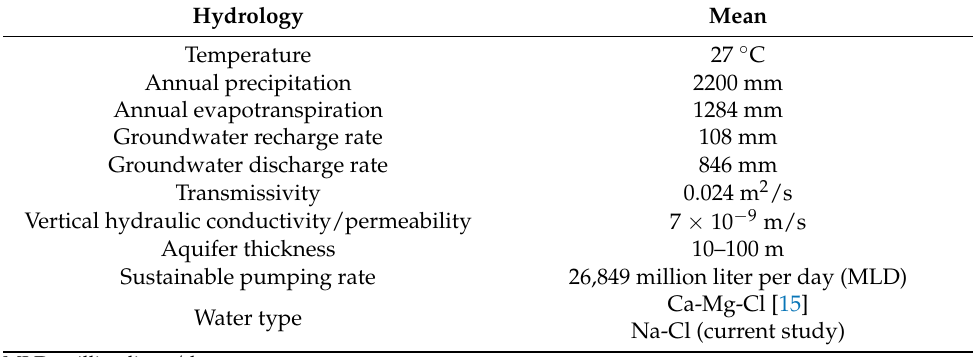
Table 3. The description of hydrogeological and hydrochemical properties of the Langat Basin [34].